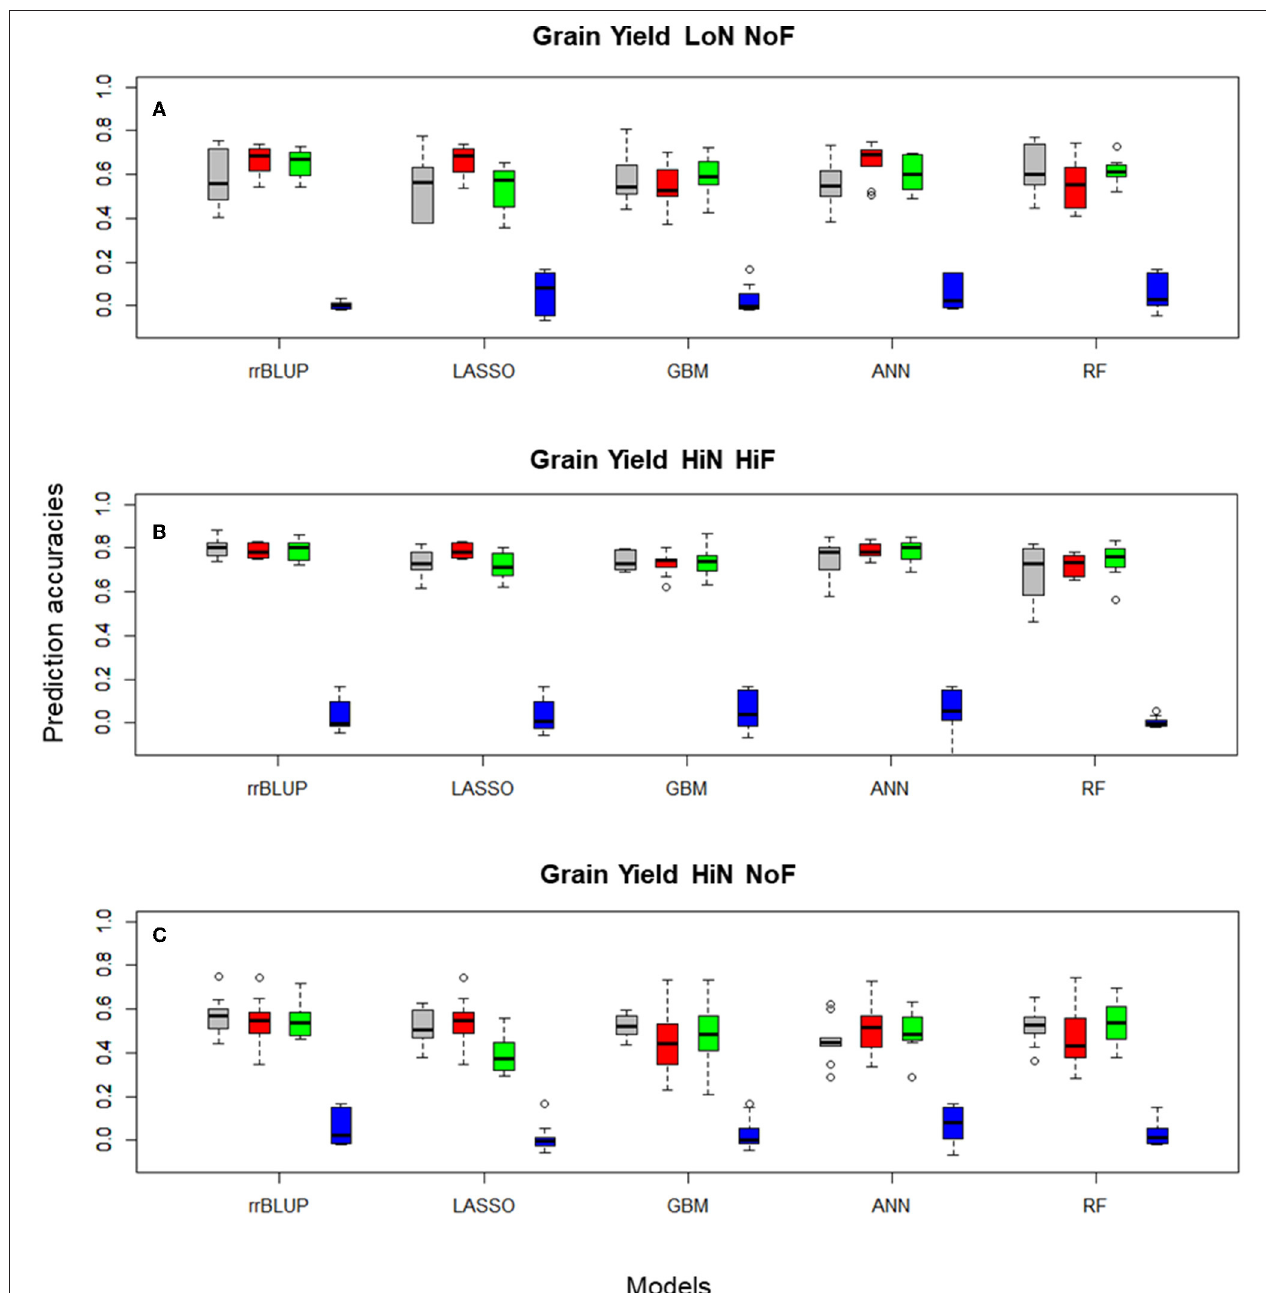
FIGURE 3 | Boxplots for wheat (A) grain yield LoN/NoF, (B) grain yield HiN/HiF, and (C) grain yield HiN/NoF predictions of the Triticum aestivum 191 commercial cultivars obtained in 10-fold cross-validation (CV) sets, using Pearson’s correlations, with rrBLUP, LASSO, GBM, ANN, and RF, with 100, and 1,000 SNP subsets selected with different filtering methods and the entire SNP data set (colored in gray). Filtering methods: principal component analysis 100 PCA (red), 1,000 RF (green), 1,000 RS (blue), and 14,718 (gray, no FS using the total number of markers after